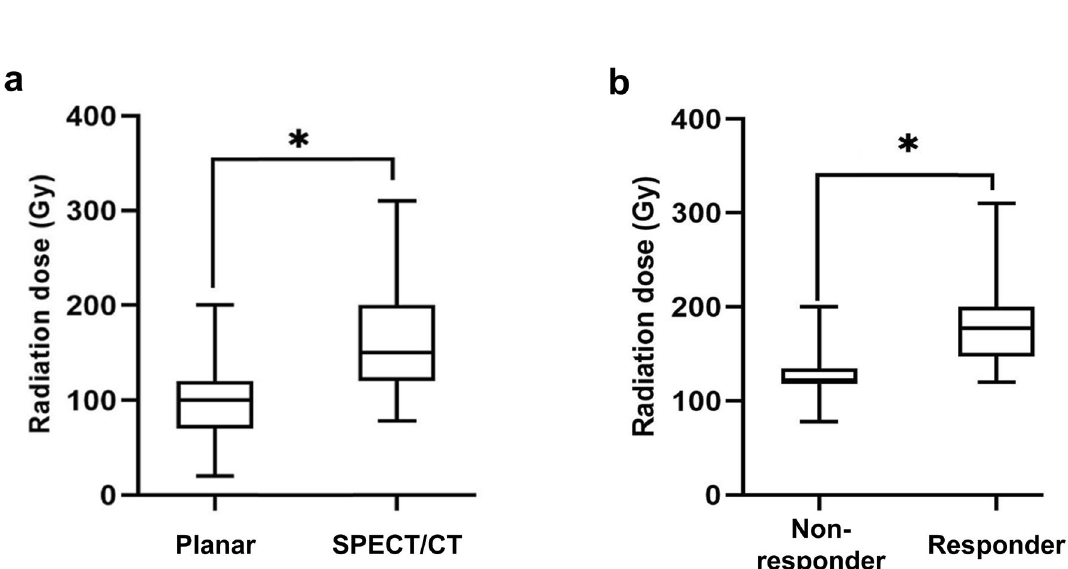
Figure 4. D tumor values measured on planar image and SPECT/CT. ( a ) D tumor was significantly higher on SPECT/CT than on planar image. ( b ) D tumor of responder was significantly higher than that of